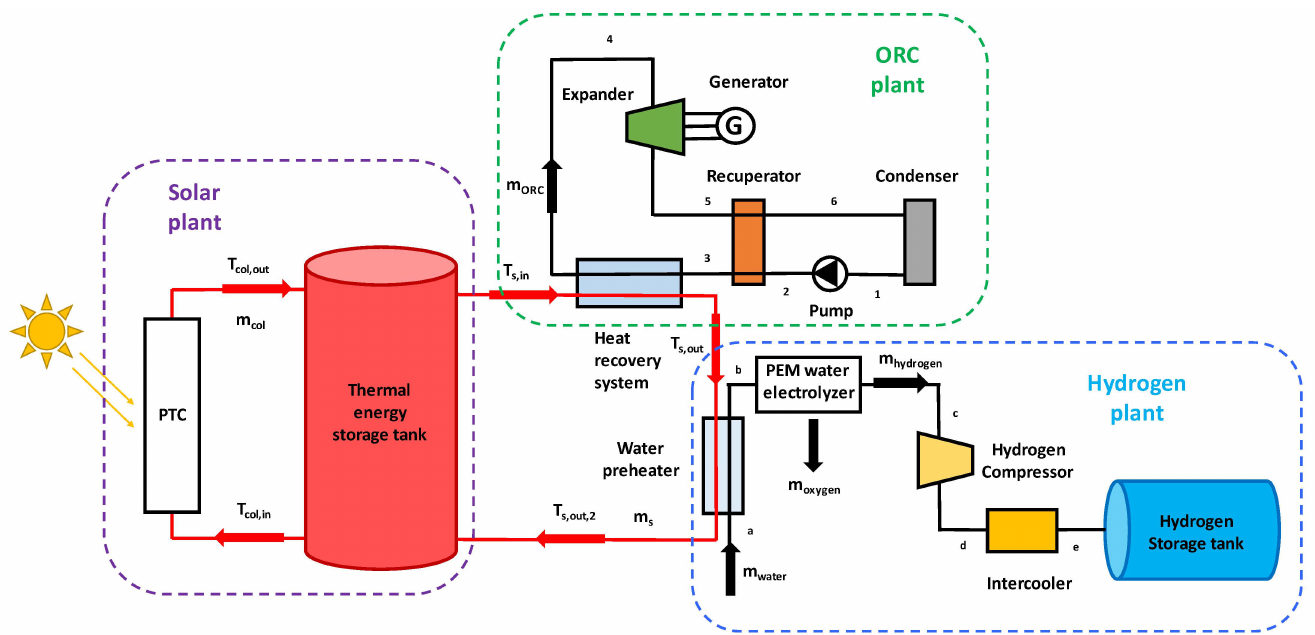
Figure 1. The proposed solar-fed energy system for electricity and hydrogen